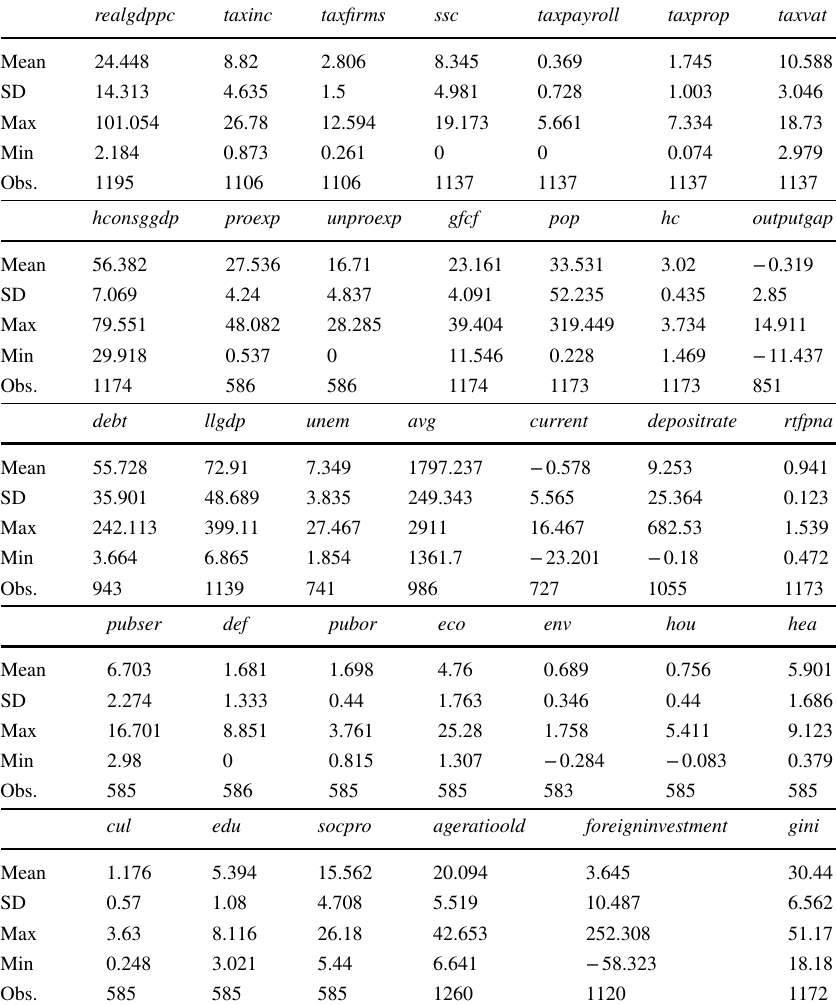
Table 1 Summary statistics of the variables set for income, consumption and inequalities,